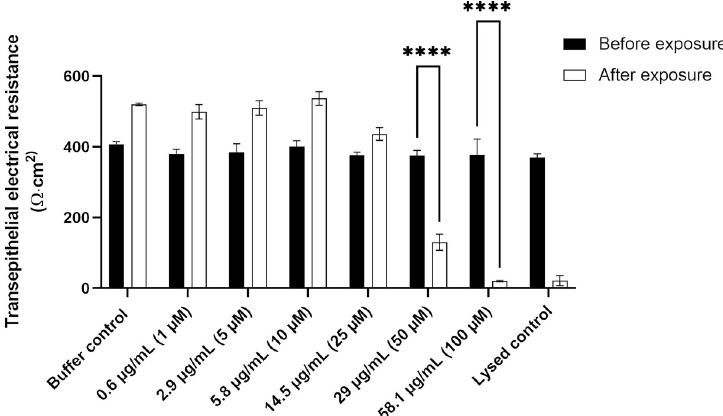
Fig 1. Transepithelial electrical resistance of JBC 1847. The figure shows the transepithelial electrical resistance (TEER) measured across Caco-2 cell monolayers before and after exposure to different concentrations of JBC 1847. Values on the x-axis represent measured TEER values across cell monolayers exposed to either transport buffer, different concentrations of JBC 1847 (0.6 μ g/ml- 58.1 μ g/ml) or purified water. Data is shown as mean ± SD of triplicates (n = 3). The measured TEER after exposure to 29 μ g/ml and concentrations above was significantly reduced ( � ) compared to the measured resistance before